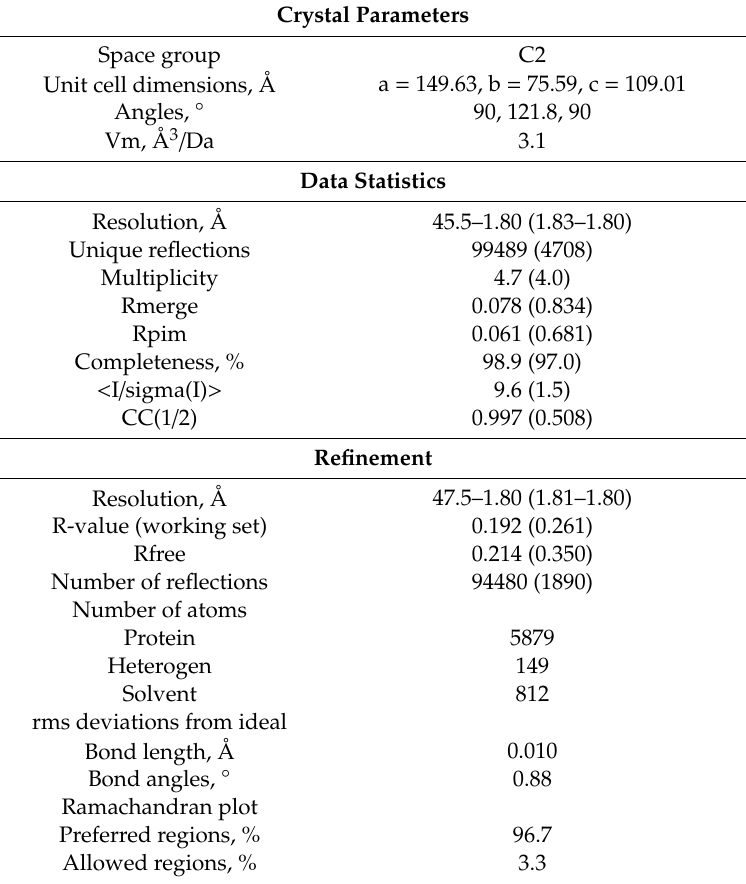
Table 1. Crystallographic data and refinement statistics.